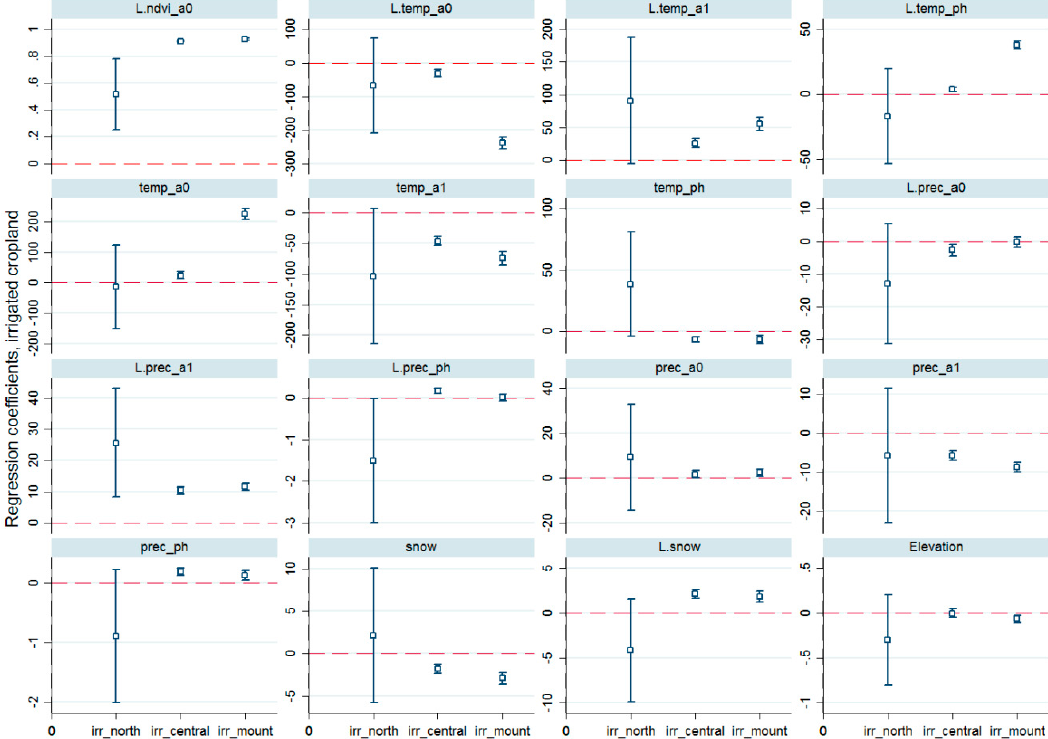
Figure 4. Regression coefficients of generalized least-squares random effect (GLS-RE) models depict relation of inter-annual vegetation dynamics and non-standardized factors within irrigated croplands of post-Soviet Central Asia. The squares represent the variable estimates and the vertical lines depict 95% confidence intervals. The range of parameter estimates is displayed on the y-axis, each of the variable labels (see Table 1) are displayed on the top of each individual plot, and names of different sub-regions are displayed on the x-axis. For clarity, a horizontal red line has been drawn at the zero value. *irr_north = northern irrigated, irr_central = central irrigated, irr_mount. = mountainous irrigated sub-regions.